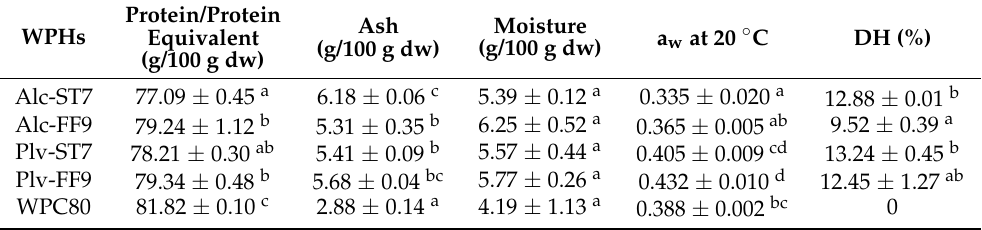
Table 1. Proximate composition, water activity (a w ) and the degree of hydrolysis (DH) of spray-dried whey protein hydrolysates (WPHs) generated with Alcalase ® (Alc) and Prolyve ® (Plv) under pH-stat (ST7) and free-fall (FF9) conditions compared to whey protein concentrate (WPC80). Protein/Protein Moisture Ash WPHs Equivalent a w at 20 ◦ C DH (%) (g/100 g dw) (g/100 g dw) (g/100 g dw) Alc-ST7 77.09 ± 0.45 a 6.18 ± 0.06 c 5.39 ± 0.12 a 0.335 ± 0.020 a 12.88 ± 0.01 b Alc-FF9 79.24 ± 1.12 b 5.31 ± 0.35 b 6.25 ± 0.52 a 0.365 ± 0.005 ab 9.52 ± 0.39 a Plv-ST7 78.21 ± 0.30 ab 5.41 ± 0.09 b 5.57 ± 0.44 a 13.24 ± 0.45 b Plv-FF9 79.34 ± 0.48 b 5.68 ± 0.04 bc 5.77 ± 0.26 a 0.432 ± 0.010 d 12.45 ± 1.27 ab WPC80 81.82 ± 0.10 c 2.88 ± 0.14 a 4.19 ± 1.13 a 0.388 ± 0.002 bc